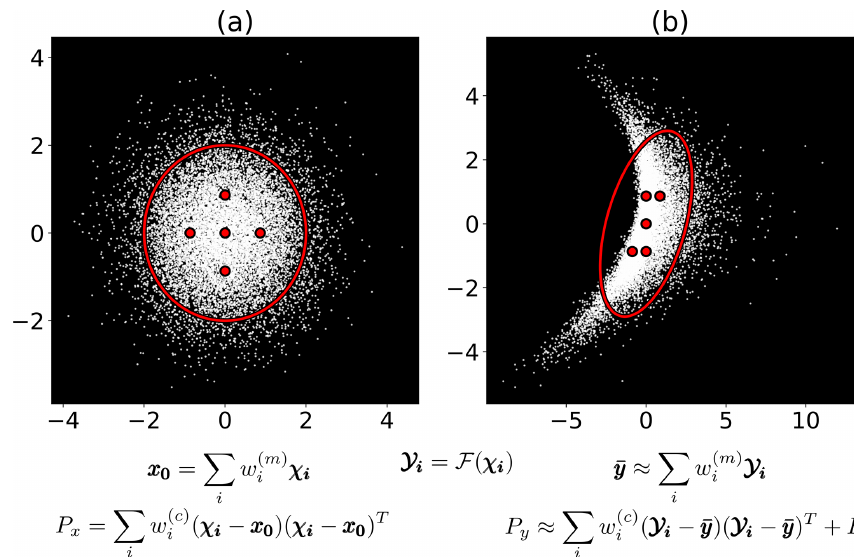
Figure 2. (a) White points are samples from a 2D Gaussian distribution x ∼ N ( 0 ,I ). The red ellipse represents the covariance of the distribution, while red points are sigma points χ i used for the unscented transform (UT). (b) White points are samples from the transformed, non-Gaussian distribution for y = F ( x ) + (cid:15) with (cid:15) ∼ N ( 0 , R ). Red points are transformed sigma points Y i = F ( χ i ). UT approximations of the mean y and covariance P y of y are estimated via weighted sums of transformed sigma